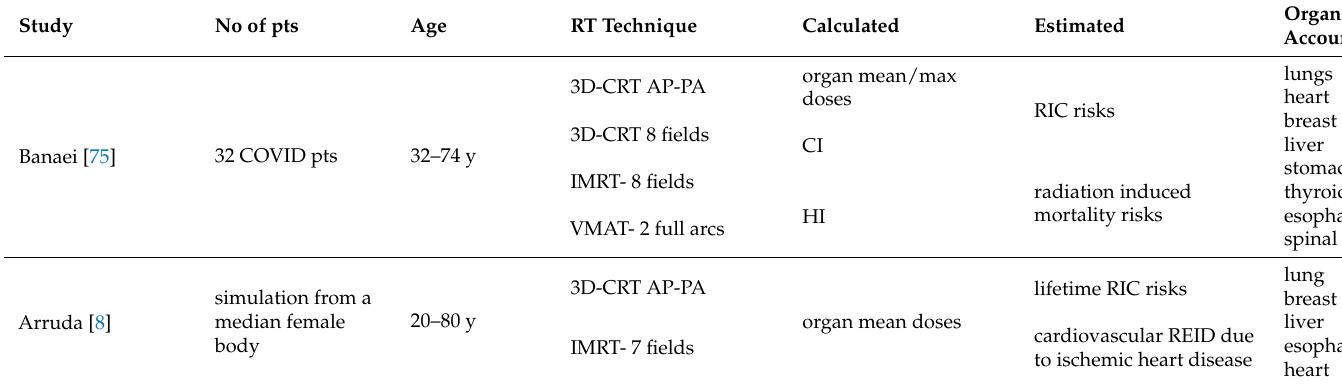
Table A4. LDRT techniques used and methodology adopted for the assessment of radiation-induced risk